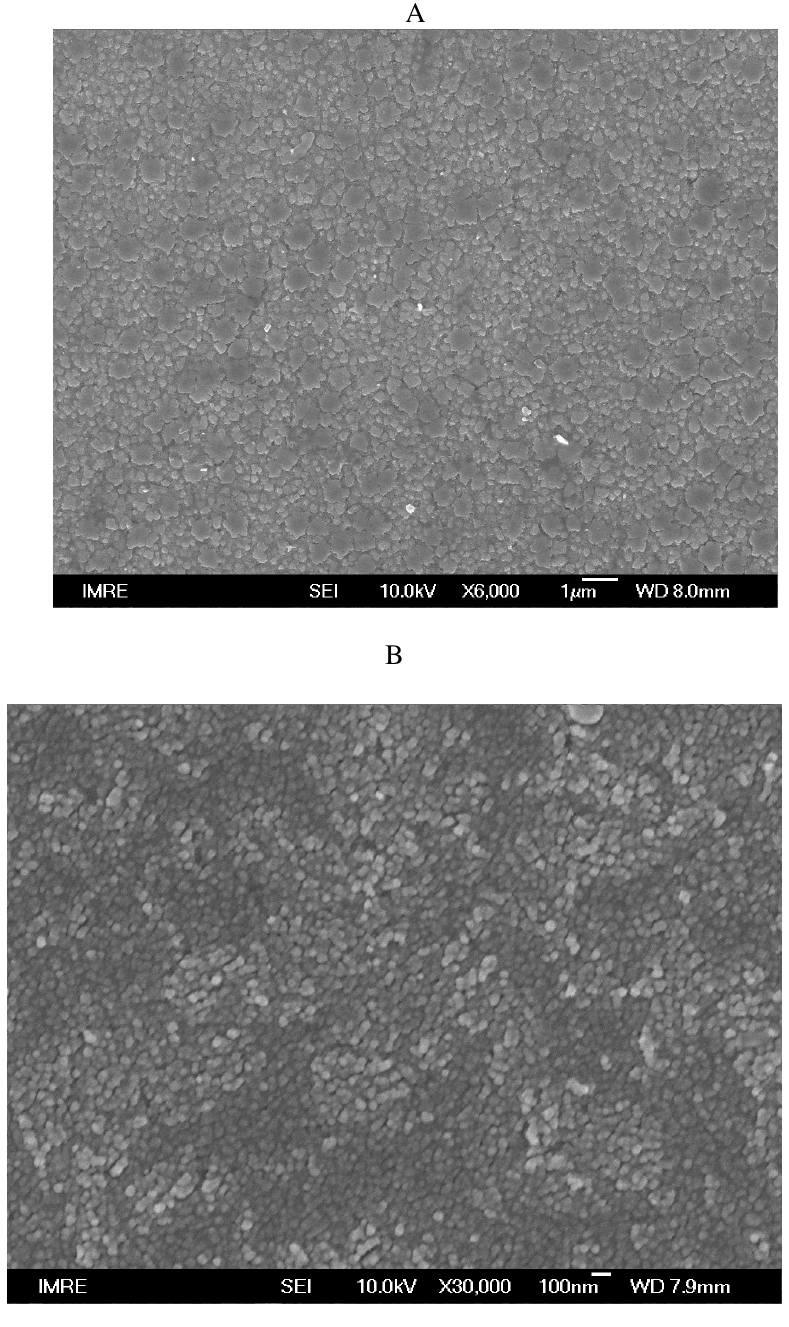
Figure 5 (A). Surface SEM photo of sample prepared under 300 (cid:176) C with annealing time of 45mins;